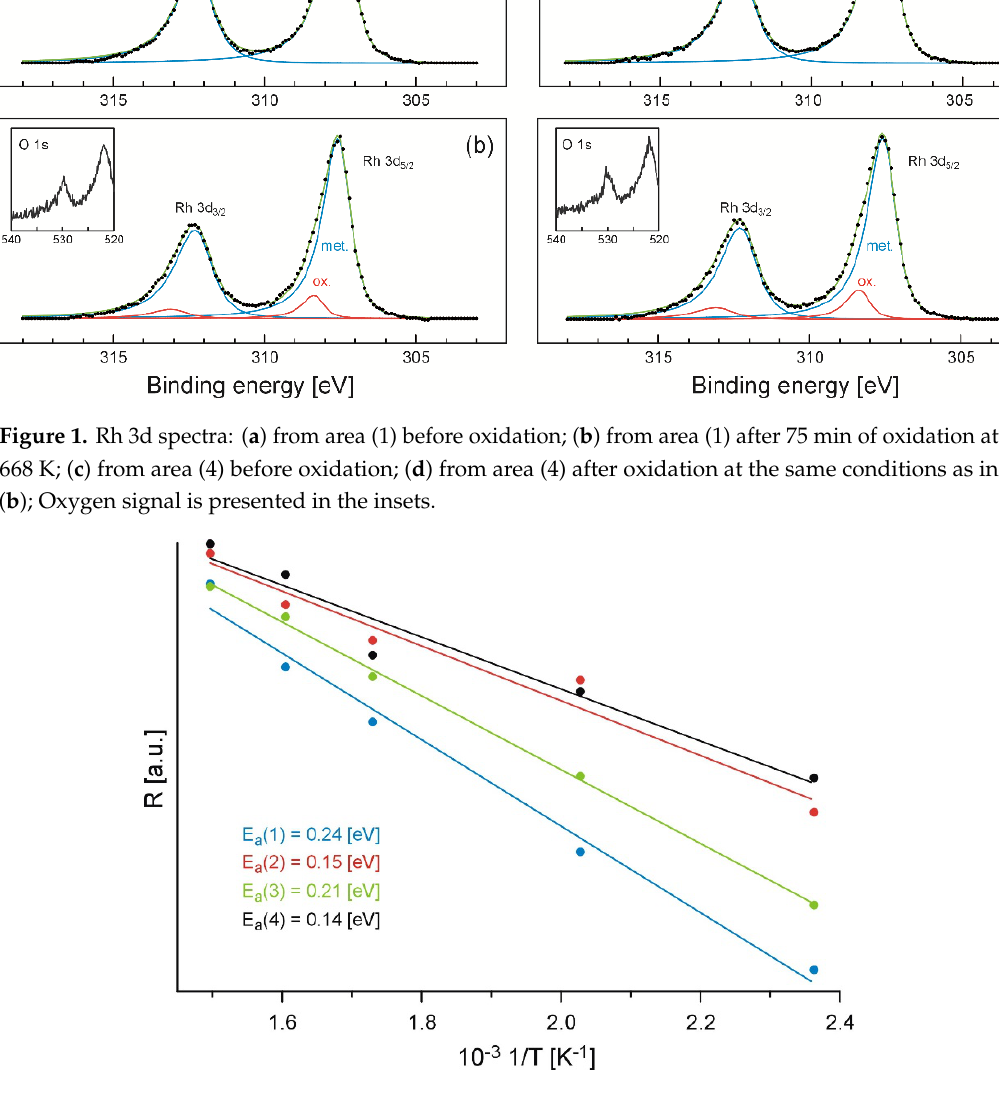
Figure 1. Rh 3d spectra: ( a ) from area (1) before oxidation; ( b ) from area (1) after 75 min of oxidation at 668 K; ( c ) from area (4) before oxidation; ( d ) from area (4) after oxidation at the same conditions as in (b); Oxygen signal is presented in the insets.